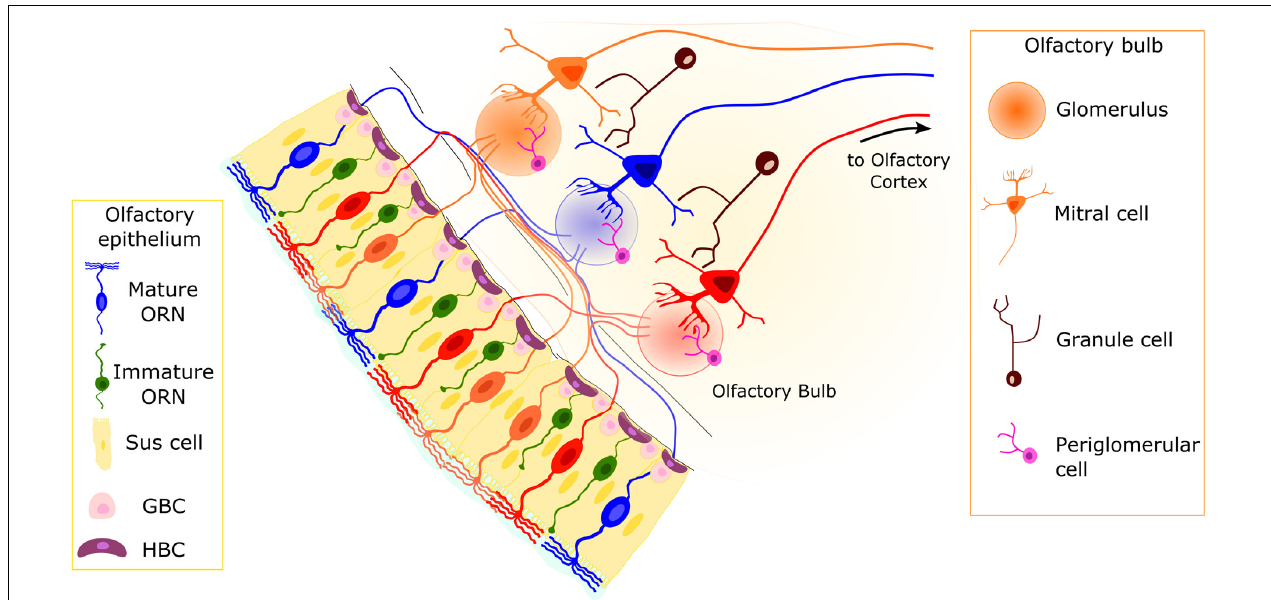
FIGURE 1 | Organization of the olfactory system. The pseudostratified olfactory epithelium (OE) consists of sustentacular (Sus) cells, olfactory receptor neurons (ORNs), and basal cells. The Sus cells have a columnar cell body, with an apical membrane with microvilli. Two main populations of neurons are present: mature and immature ORNs. Both ORN types are bipolar neurons with dendritic processes projecting toward the apical surface of the epithelium. In mature ORNs, several cilia protrude from the dendritic knob. Horizontal basal cells (HBCs) and globose basal cells (GBCs) constitute the stem cells of the OE. They are able to replace the different cell types on a daily basis or in case of injury. Axons from ORNs expressing the same odorant receptor type (represented by ORNs of the same color) converge in the olfactory bulb (OB) in round structures dense with synapses, called glomeruli. The second-order neurons (mitral/tufted cells) have a single dendrite projecting to a single glomerulus and lateral dendrites that contact dendrites of granule